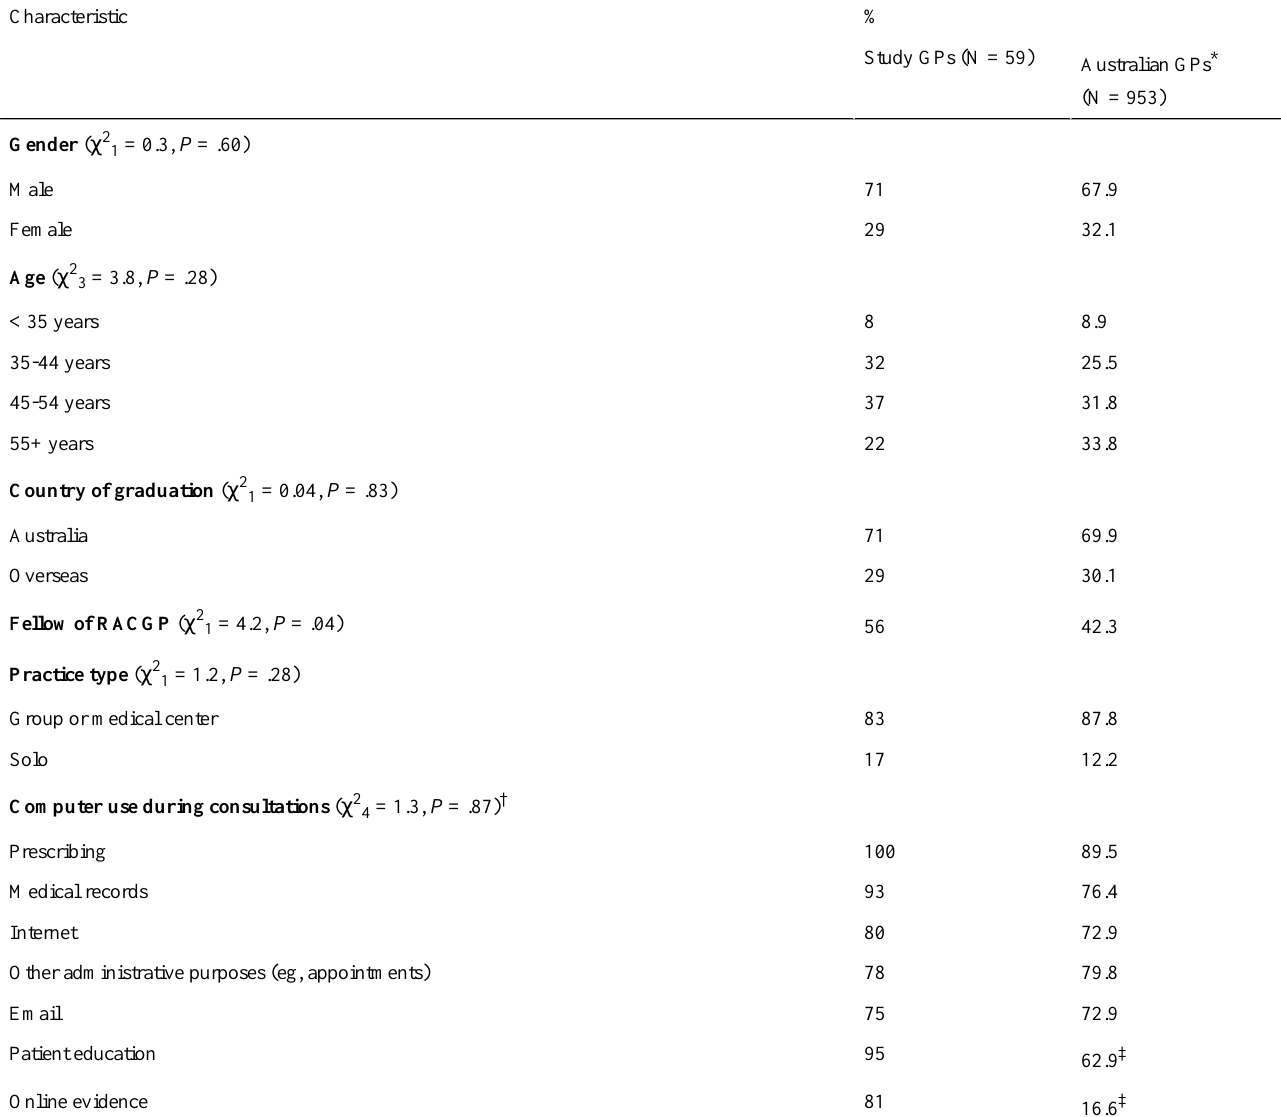
Table 1. Demographics of study GPs in comparison to the general population of Australian GPs in 2005/2006